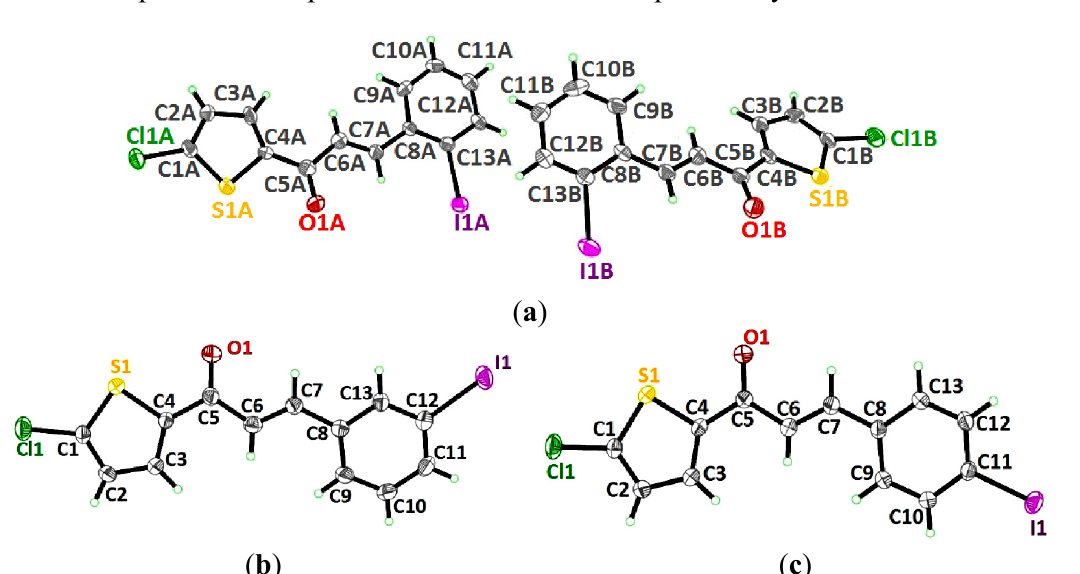
Figure 1. Molecular structures of compounds ( a ) 4a , ( b ) 4b and ( c ) 4c , with atom numbering schemes. Displacement ellipsoids are drawn at the 30% probability